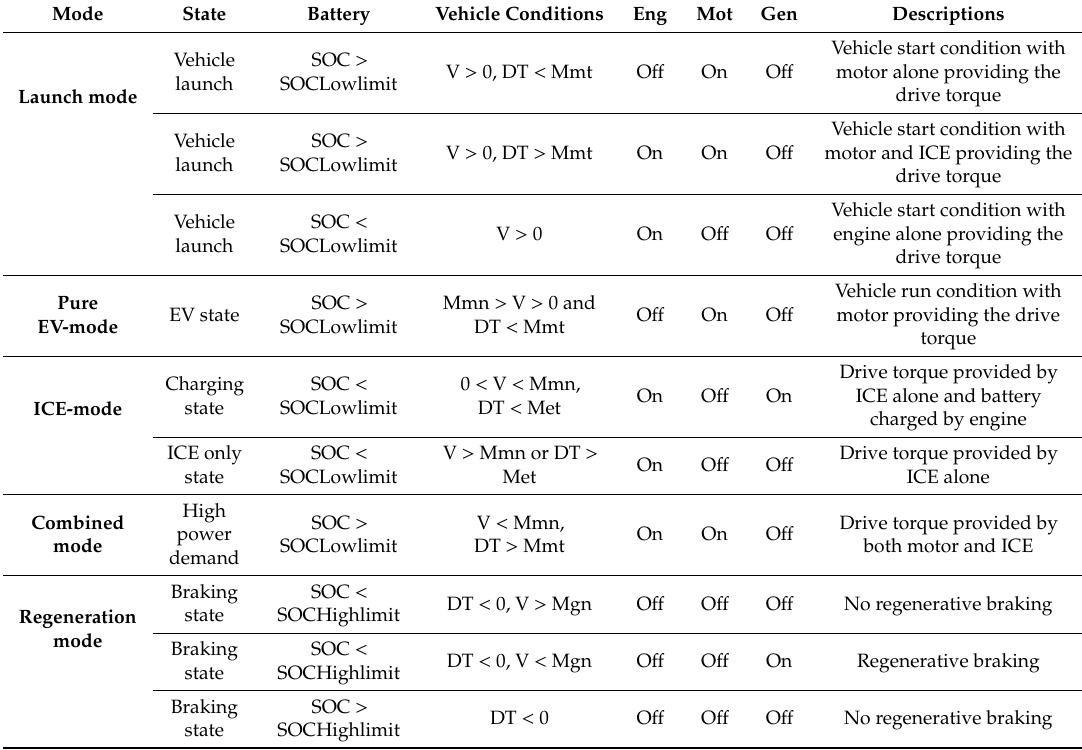
Table 2. Basic rules used in rule-based strategy existing in the hybrid two-wheeler